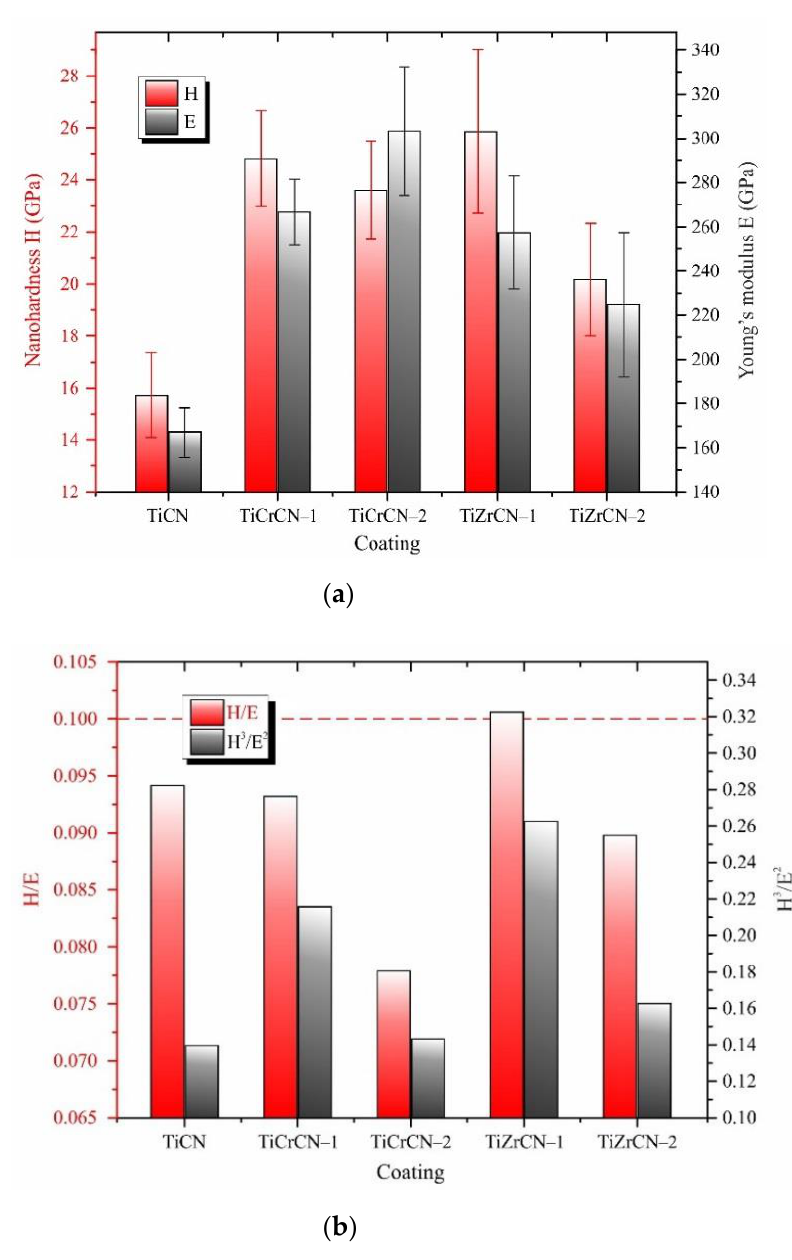
Figure 8. Nanohardness data for TiCN, TiCrCN, TiZrCN coatings on titanium VT1 – 0: ( a ) nanohard- ness and Young ’ s modulus, ( b ) H/E and H 3 /E 2 values.